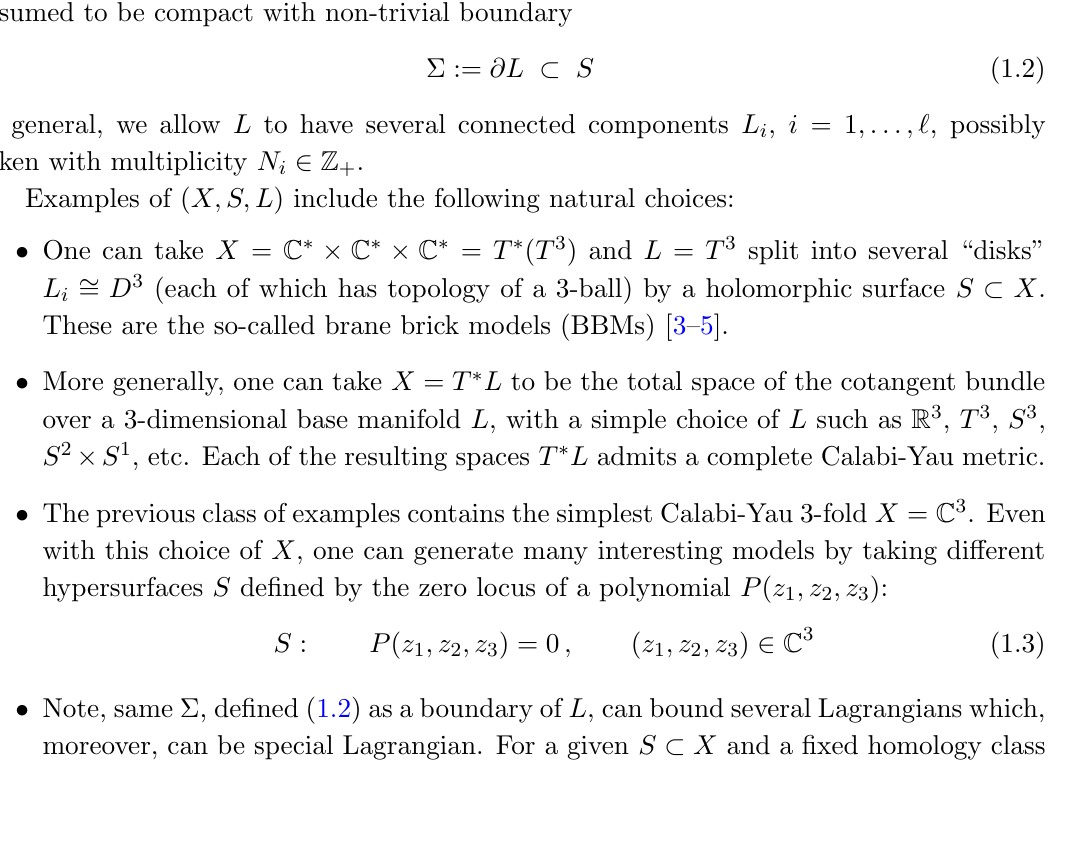
Figure 1 . Our geometric setup involves a holomorphic surface S in a Calabi-Yau 3-fold X , and a special Lagrangian submanifold L (cid:26) X with boundary (cid:6) := @L (cid:26) S . ( X ; M ) of a G holonomy manifold X and a coassociative submanifold M in it. A 7 4 2 7 4 repeated application of this \M-theory lift" | denoted by squiggly arrows in (1.1) | similarly associates a Spin(7) holonomy manifold X to the pair ( X ; M ). As a result, the 8 7 4 same triple ( X; S; L ) can be analyzed from several di(cid:11)erent perspectives, which correspond to di(cid:11)erent stages of